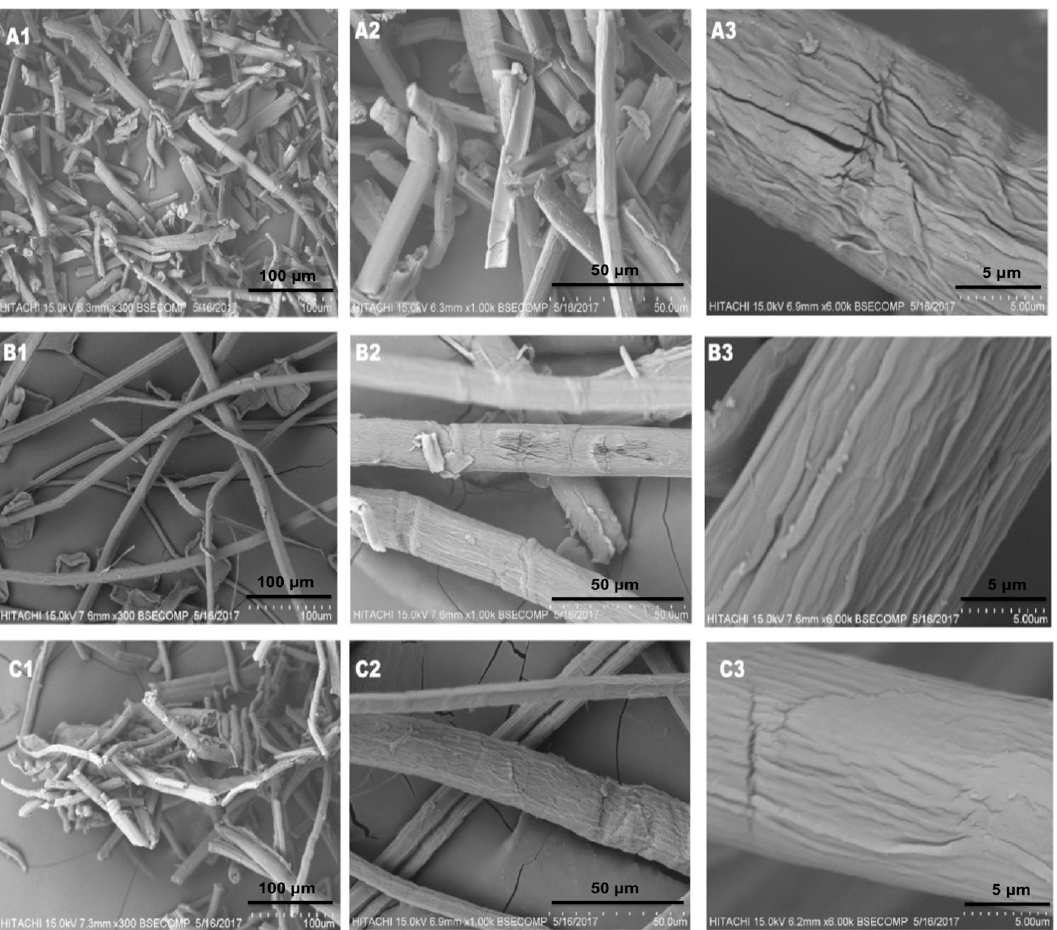
Figure 2. SEM images of isolated MCC ( A ), bleached pulp ( B ) and cooked pulp ( C ). All images are captured at the acceleration voltage of 15 kV as reported in the methods section. Samples were coated with gold before capturing images.